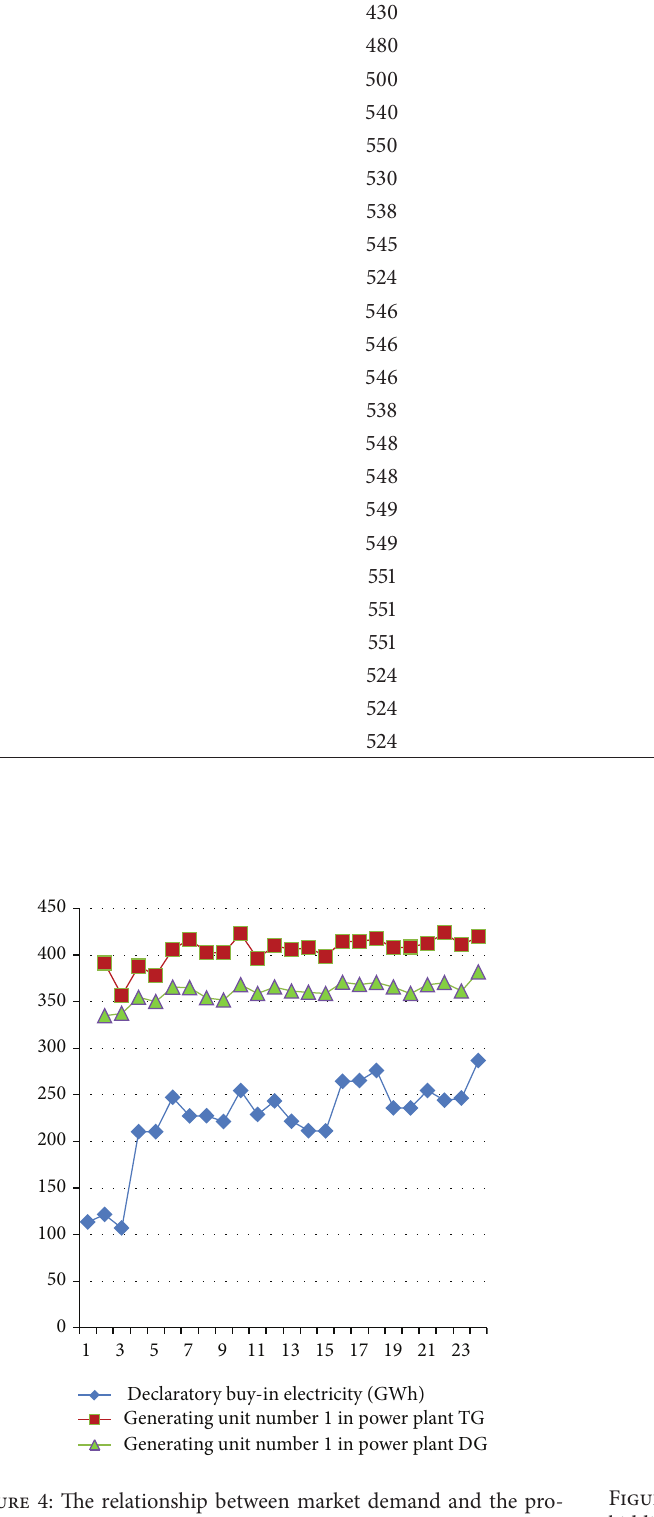
Figure 5: The relationship between ceiling price and producer’s bidding